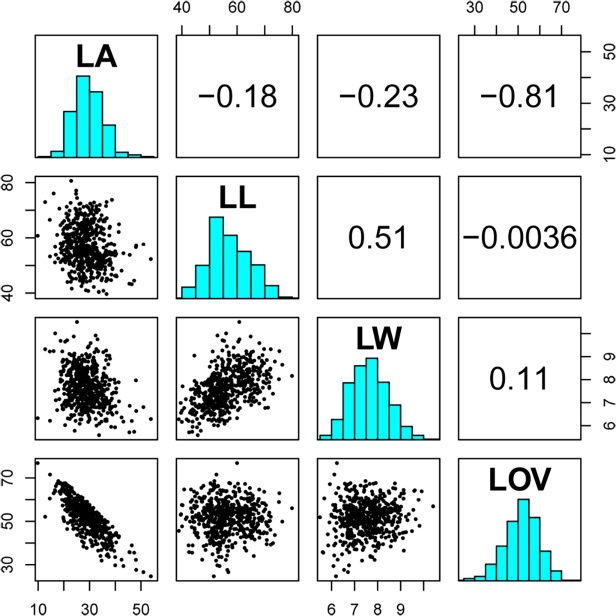
Trait correlations between LA, LL, LW, and LOV variations based on BLUP values across three populations.Right-top represents the correlation coefficients among four traits. Diagonal represents the frequency distribution for each of four traits. Left-bottom represents the scatter distribution among four traits.